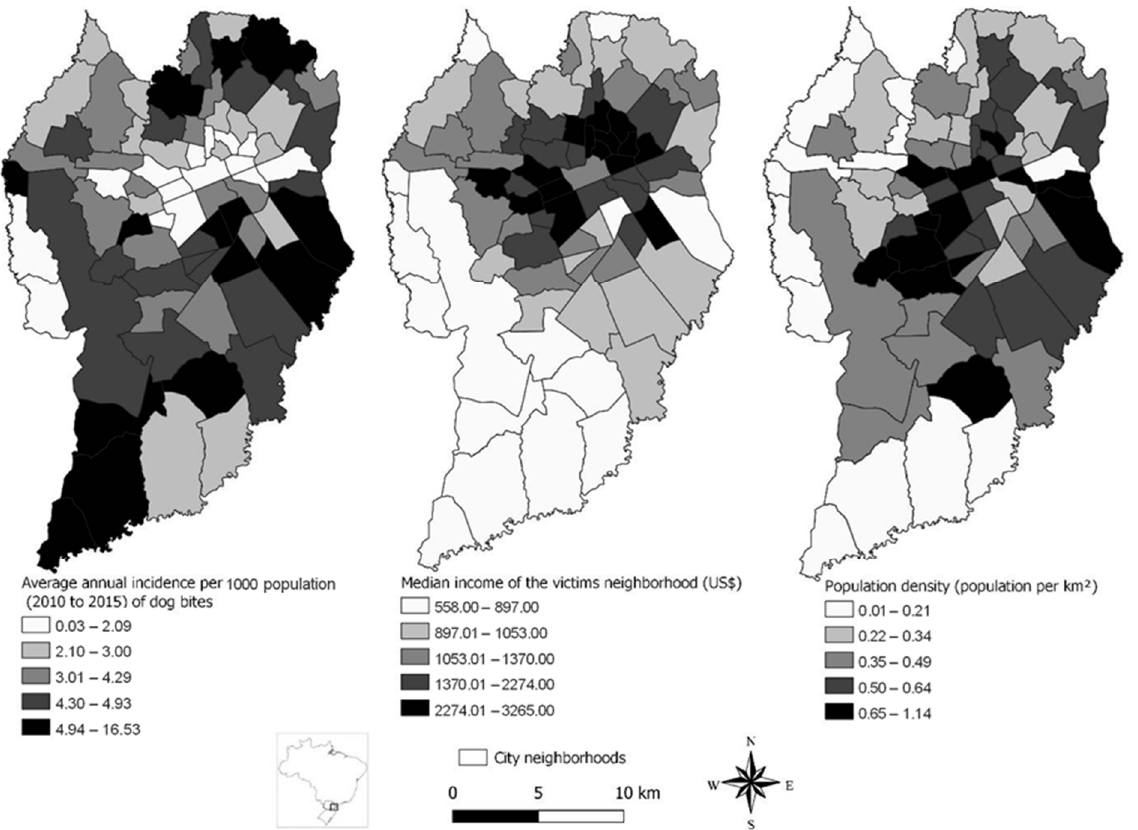
Figure 1. Geographic map of Curitiba city, Paraná State, Southern Brazil. Enlarged Curitiba maps show the spatial distribution of the average annual incidence of dog bites by victims’ neighborhood, the median income of the victims’ neighborhood, and human population density by neighborhood per km 2 from 1 January 2010 to 31 December 2015 in Curitiba, Parana State, Southern Brazil.